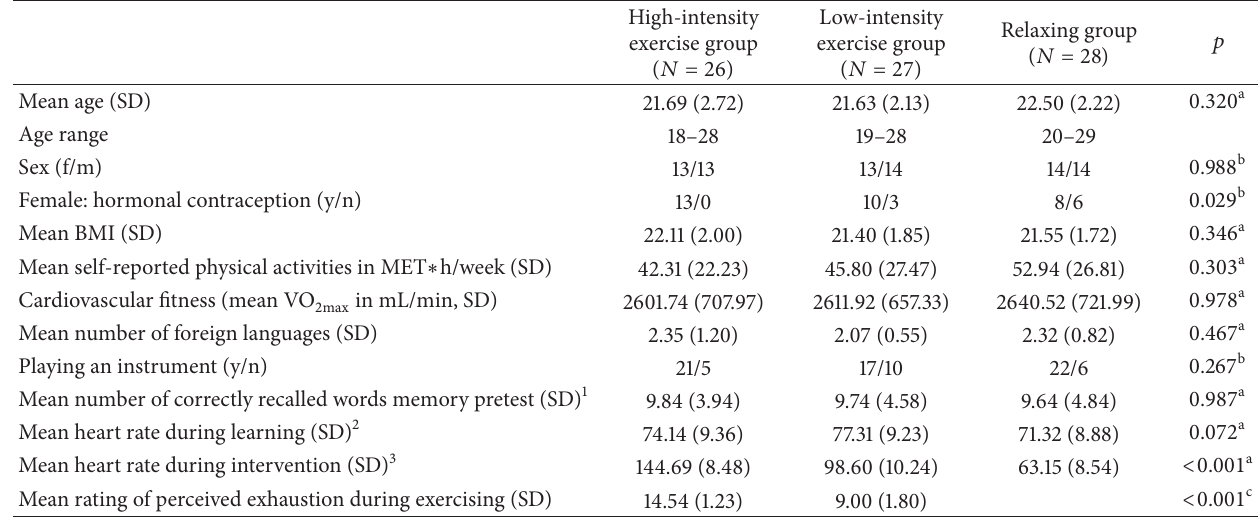
Table 1: Participants’ characteristics and exercise induced changes in heart rate and subjective exhaustion, listed separately for the high- intensity exercise group, low-intensity exercise group, and relaxing